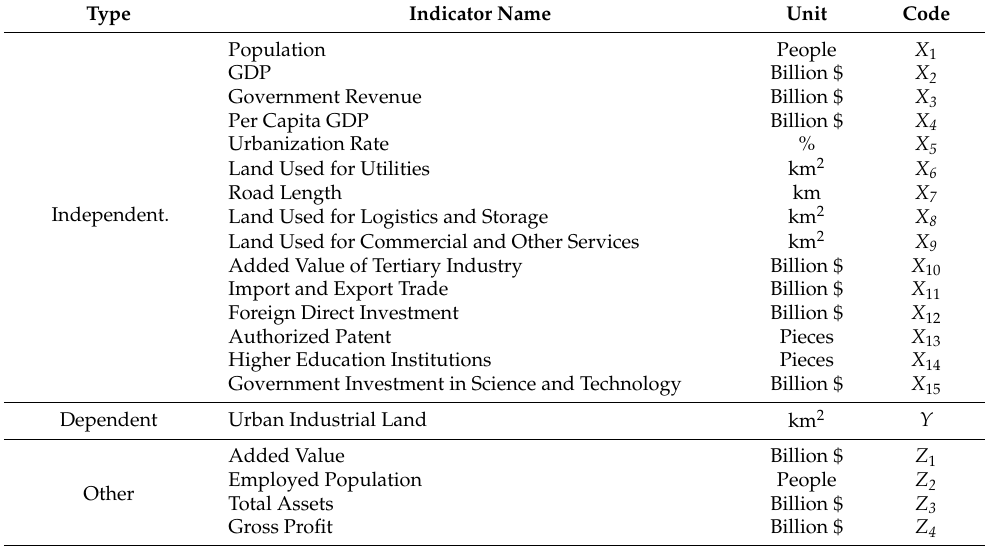
Table 1. Variable composition, type, and